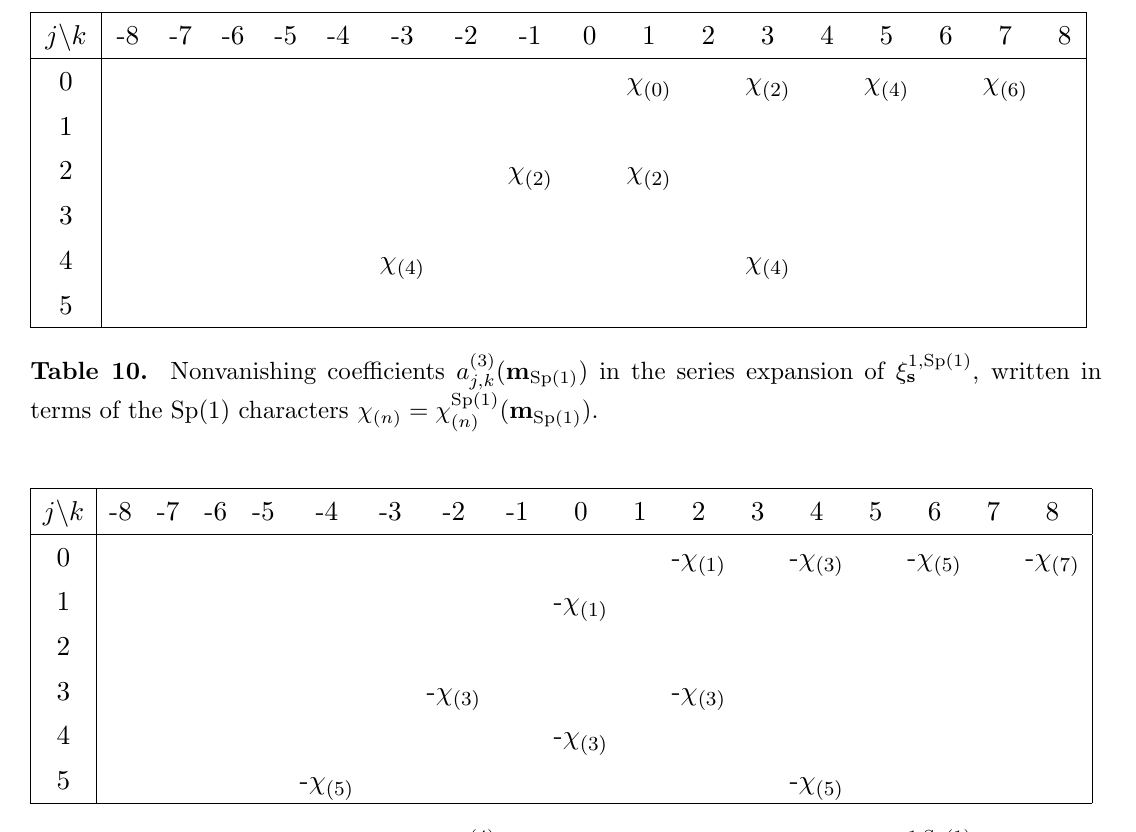
Table 11. Nonvanishing coe(cid:14)cients a (4) terms of the Sp(1) characters (cid:31)